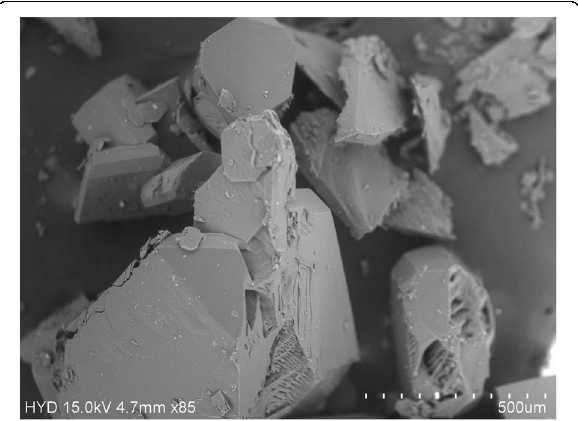
Fig. 12 SEM image of 0.218 g/ml of solute in acetone obtained by solvent evaporation method carried out for 24 h with no stir (× 60)